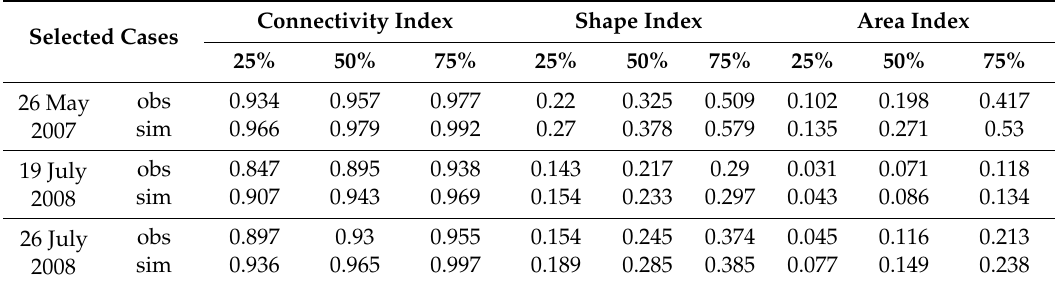
Table 4. Results of three geometric index components for sim_ref and obs_ref data sets. Values are sorted at 5, 50, and 75 percentile levels.